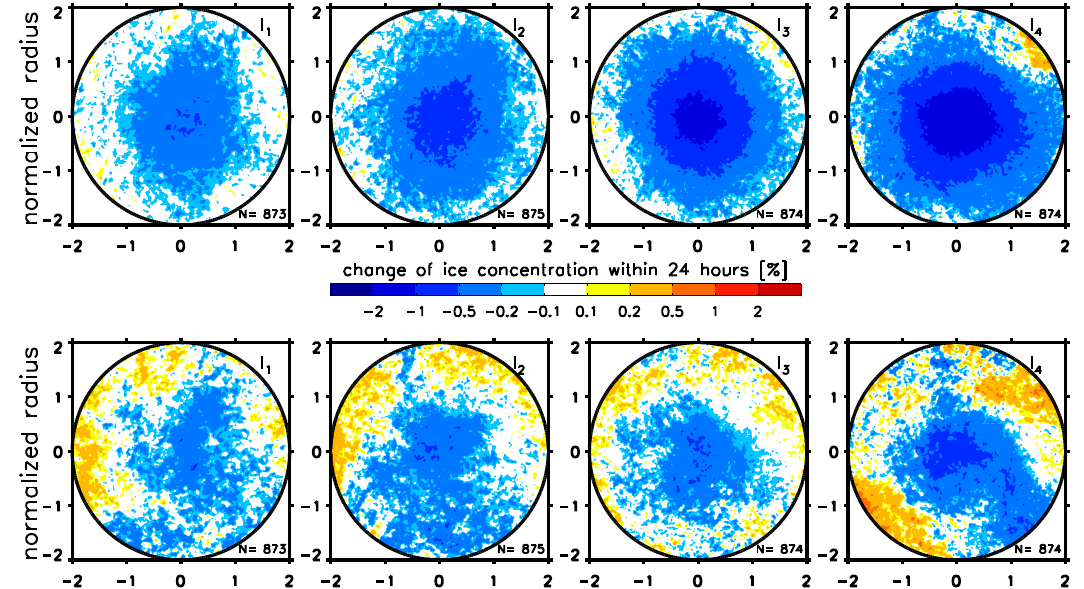
Fig. 6. Mean change of simulated (top) and AMSR-E (bottom) ice concentration within 24h after cyclone passage ( t = 0) for I 1 to I 4